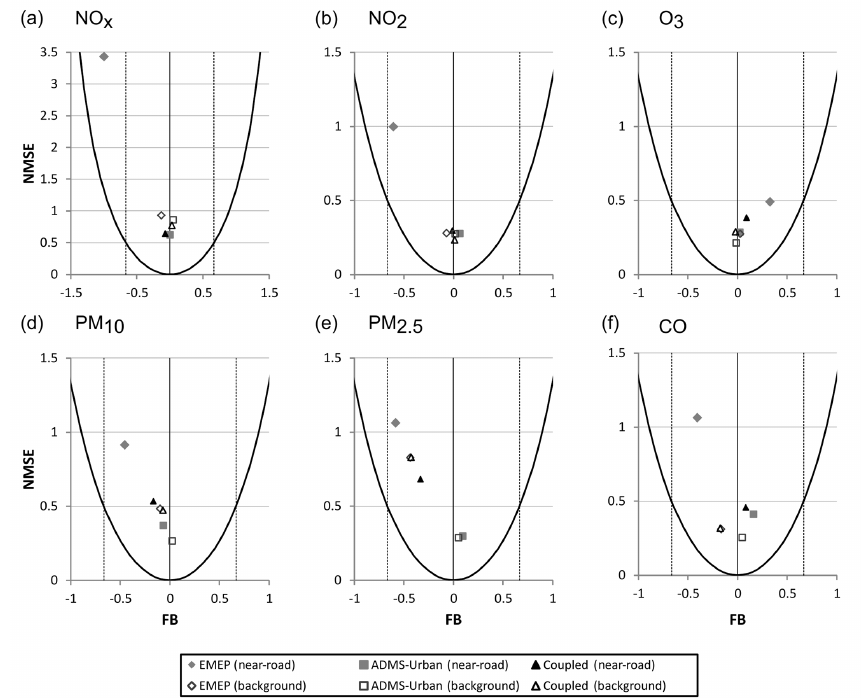
Figure A3. Model evaluation plots comparing NMSE and Fb for near-road or background sites by pollutant, where improved model perfor- mance is shown by the results closest to (0,0). The solid parabola indicates the minimum NMSE for a given Fb, while the dashed lines show modelled results within a factor of 2 of the observations. Note that the NO x plot has different axis limits to the other pollutants due to the outlying EMEP near-road